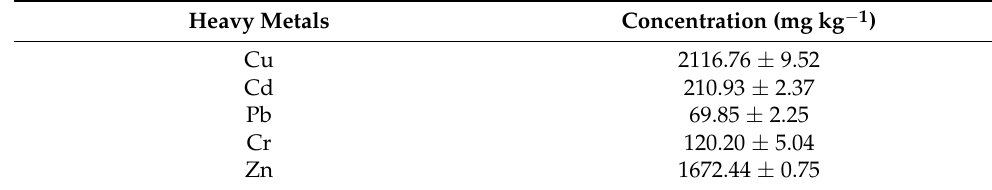
Table 1. The average concentrations of some heavy metals in oily sludge. Heavy